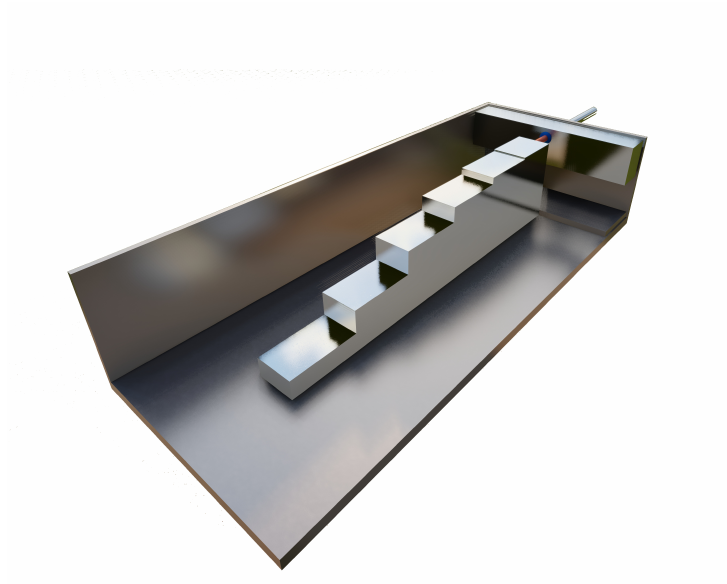
Figure 1. Geometry of the coaxial-to-waveguide transition: isometric view (the left and the upper walls are not displayed). The coaxial probe (displayed in orange) is inserted at the center of the waveguide (WG) backshort: the coaxial dielectric layer terminates in correspondence of the WG backshort face, whereas the inner conductor is shorted on the ridge. The resulting ridge WG structure is then matched to the hollow waveguide via a ridged steps